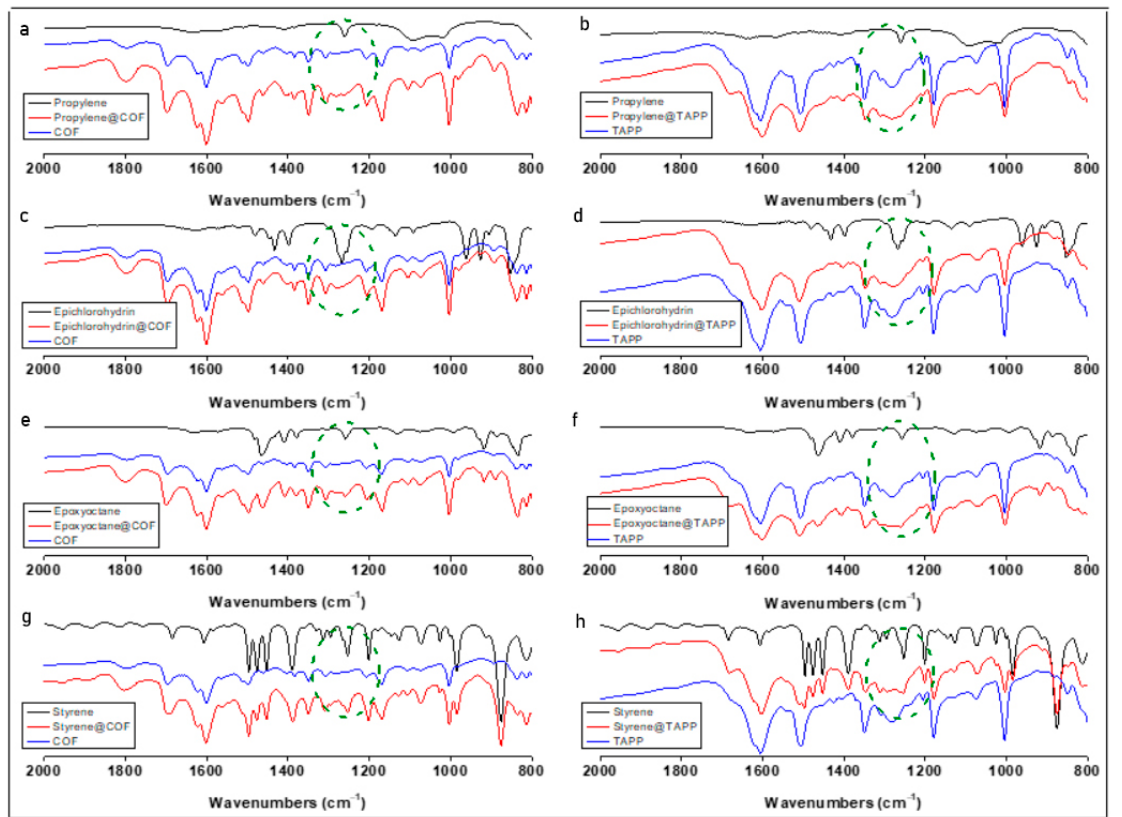
Figure 4. FT-IR spectra patterns of different sized epoxides, Co(II)@TF-TA COF, Co(II)@TAPP and their epoxide complexes. Left column: interaction information of epoxides with COF; Right column: interaction information of epoxides with TAPP. ( a – d ) Disappearance of ring vibration of C-O-C epoxy group located at 1260 cm − 1 , as marked by circle (The reason is due to the interaction of small-sized epoxides with cobalt-porphyrin); ( e , g ) Retention of ring vibration of C-O-C epoxy group (because large-sized epoxyoctane and styrene cannot interact with cobalt-porphyrin of COF); ( f , h ) Disappearance of ring vibration of C-O-C epoxy group when interacting with TAPP.